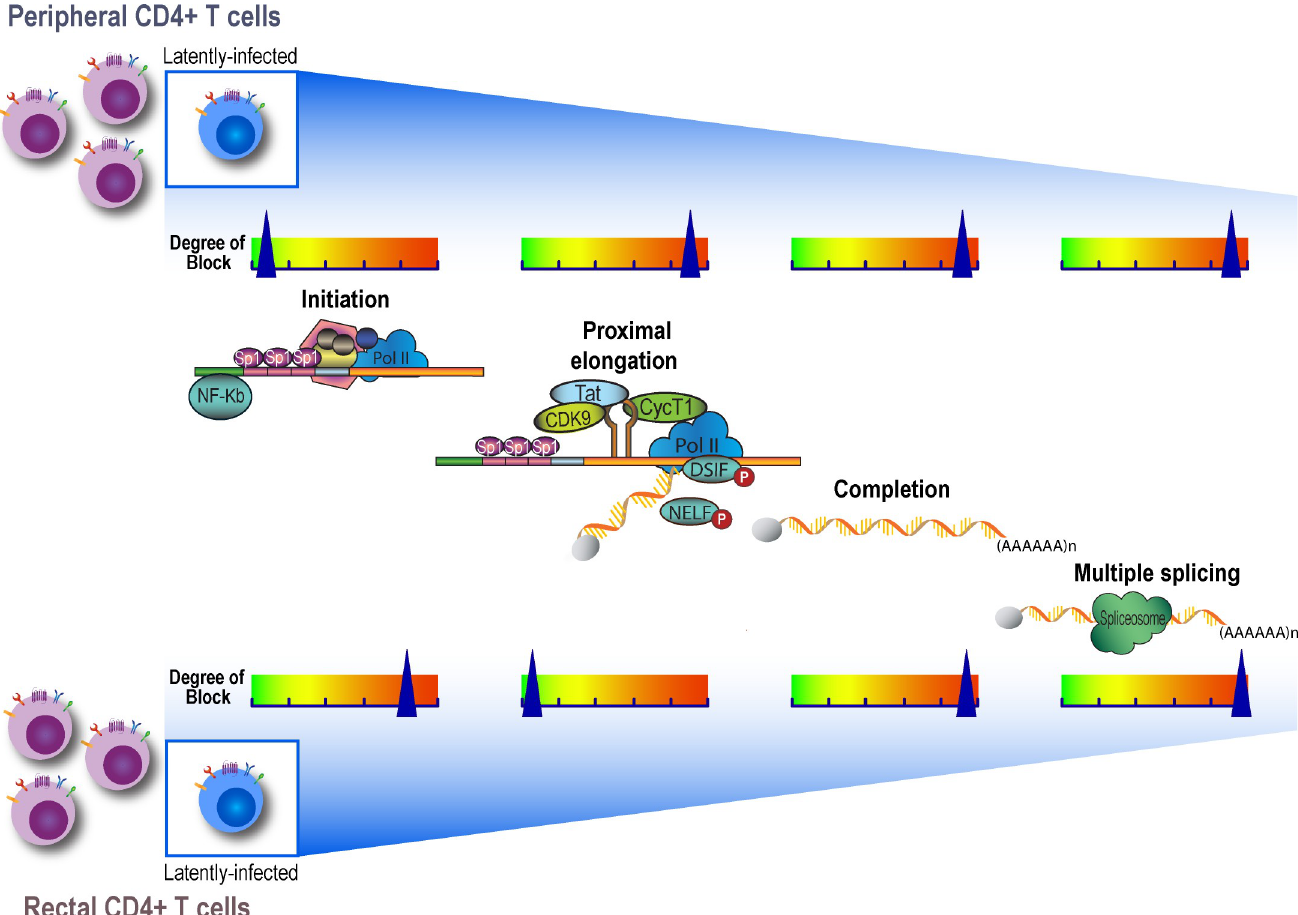
Fig 5. Blocks to HIV transcription differ in the gut and blood. Multiple blocks to HIV transcription occur in vivo and these differ in CD4+ T cells from the rectum and peripheral blood. Selected examples of potential factors are